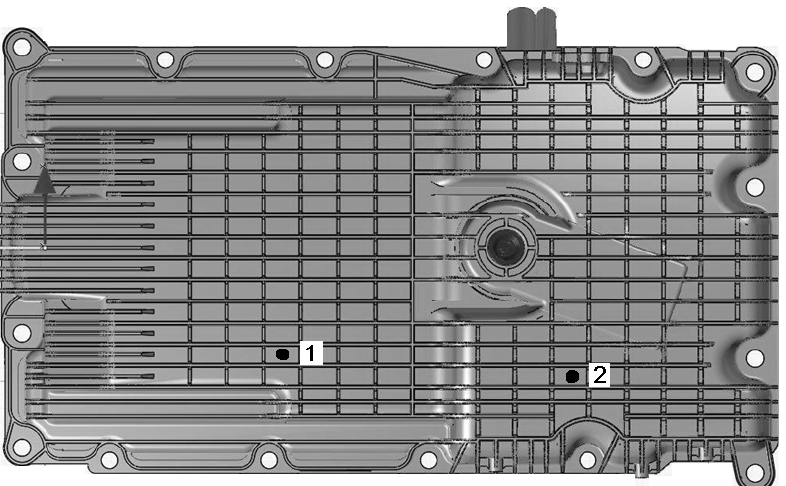
Figure 3. Two different impact locations